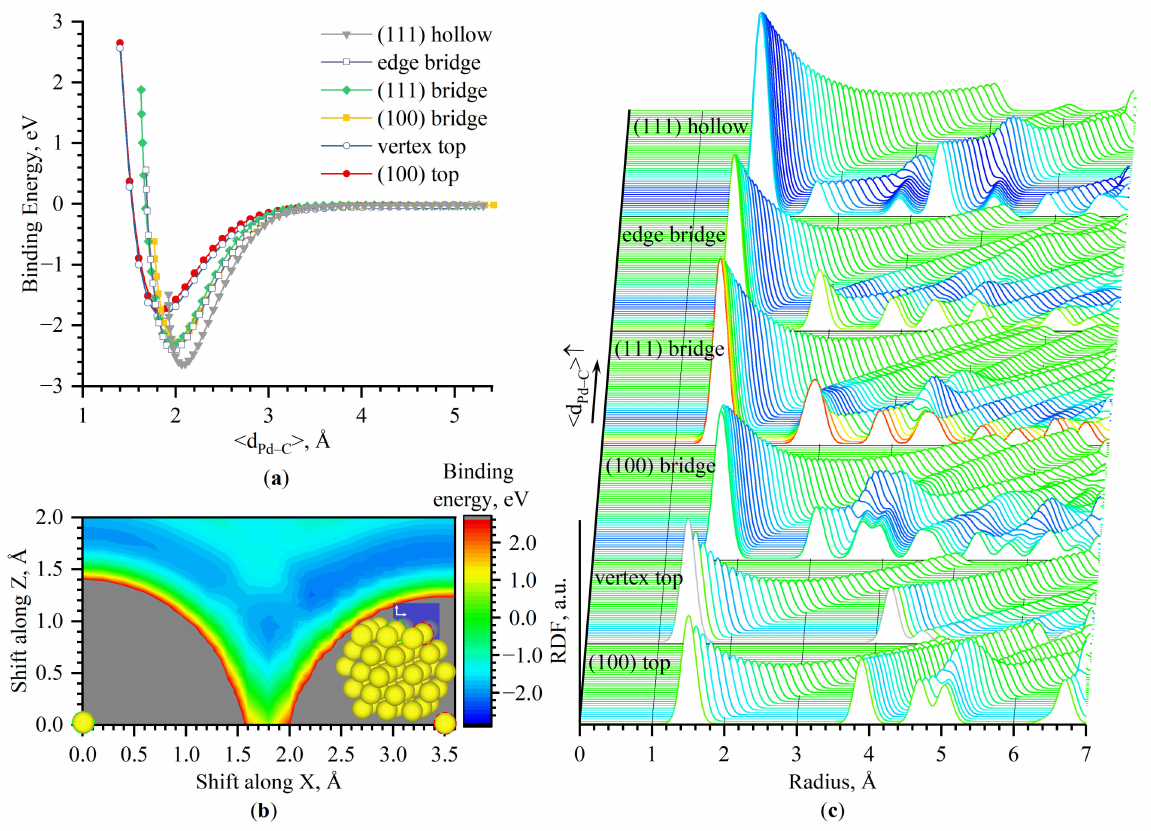
Figure 2. DFT potential energy scans upon moving CO molecules ( a ) from adsorption sites on the surface of Pd 55 nanocluster; ( b ) along the plane perpendicular to Pd(100) (nearest Pd atoms are marked by red and green dashes). ( c ) Series of smeared RDF upon CO moving away from the respective adsorbing site, colored according to binding energies. The color scale is the same for parts ( b , c